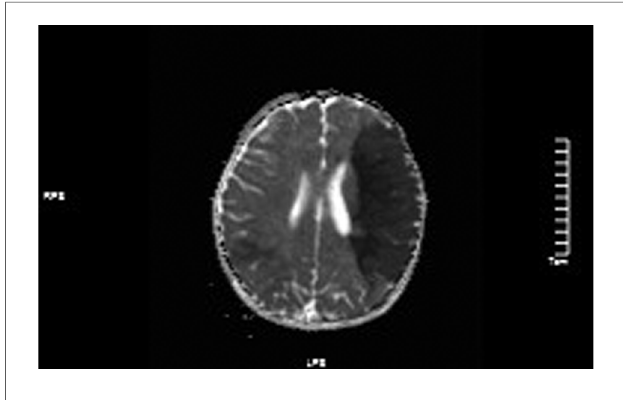
FIGURE 4 ADC values decreased in the left frontotemporal lobe and the right temporo-occipital lobe.